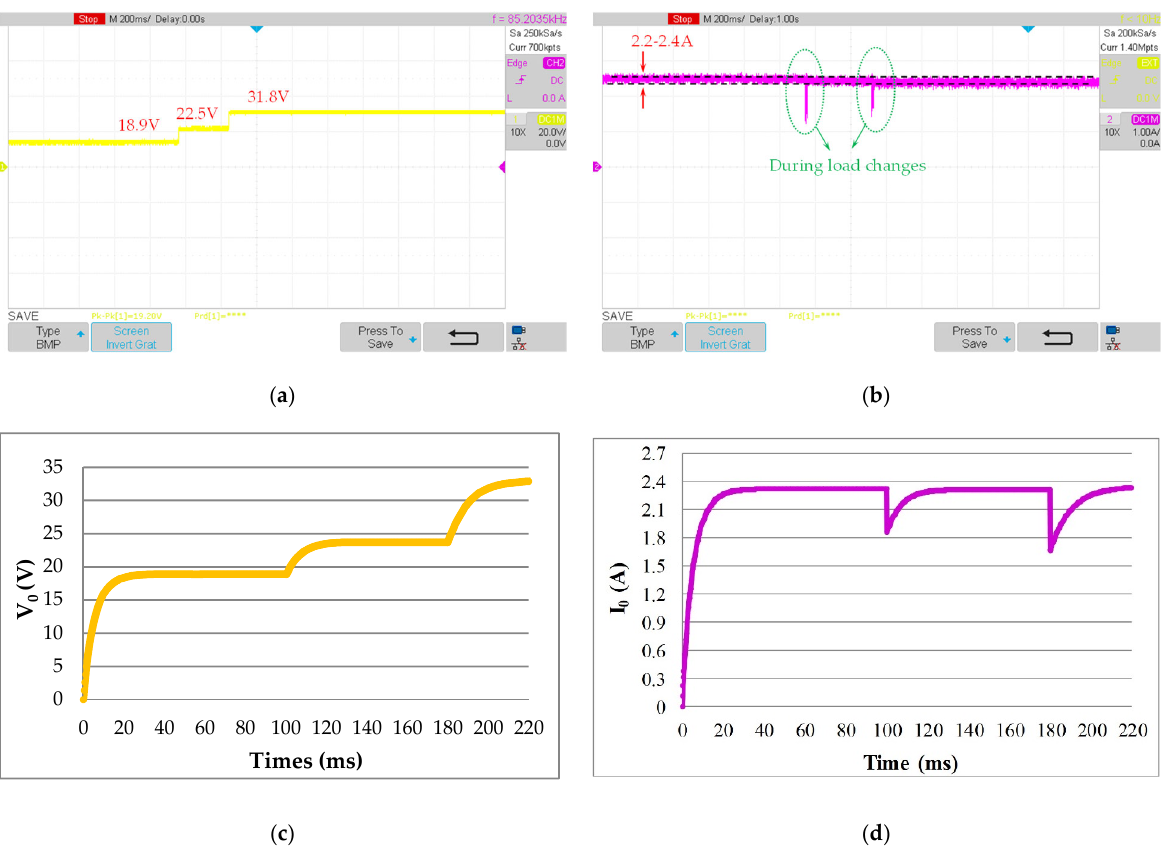
Figure 7. ( a ) measured 𝑉 (cid:3016) ; ( b ) measured 𝐼 (cid:3016) ; ( c ) simulated 𝑉 (cid:3016) ; ( d ) simulated 𝐼 (cid:3016) when 𝑅 (cid:3013) is 8.5 Ω , Figure 7. ( a ) measured V O ; ( b ) measured I O ; ( c ) simulated V O ; ( d ) simulated I O when R L is 8.5 Ω , 10.5 Ω , and 14 Ω , respectively. 10.5 Ω , and 14 Ω ,